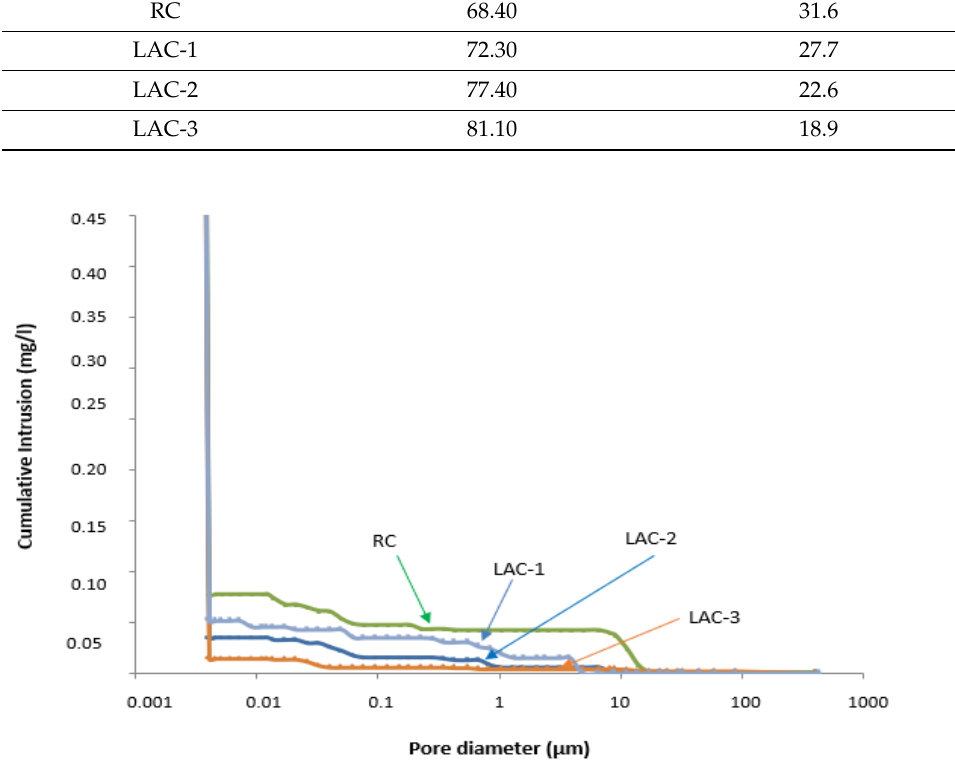
Table 3. Water permeability and chloride penetrability test.